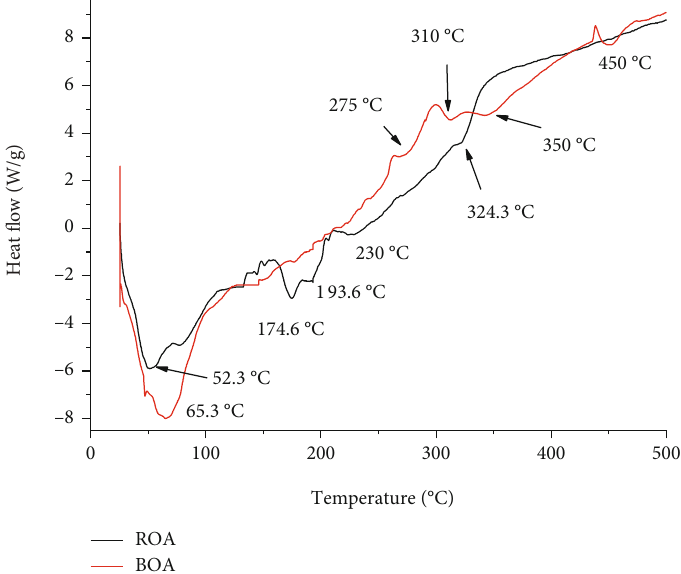
Figure 11: DSC image of ROA and BOA fi